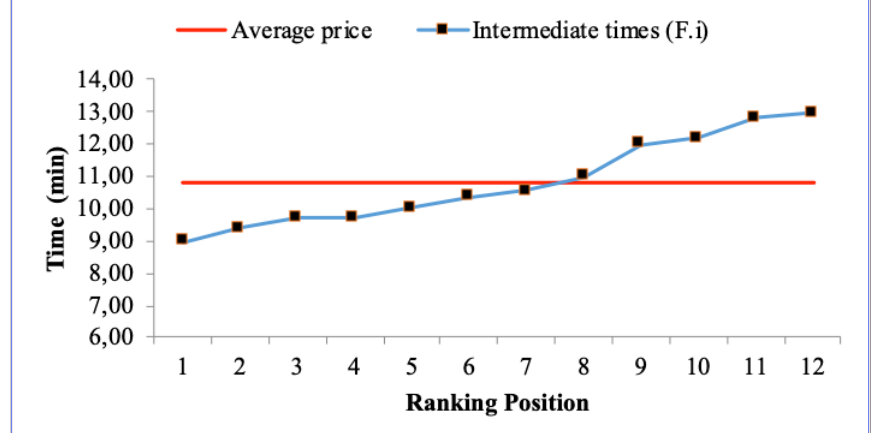
Figure 1 . An intermediate time in the respective sections (F.i) of women’s 20km of race walking in relation to their classification position.